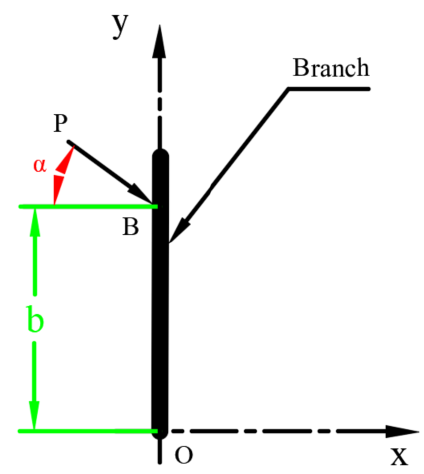
Figure 16. Schematic diagram of the forces on the branches.